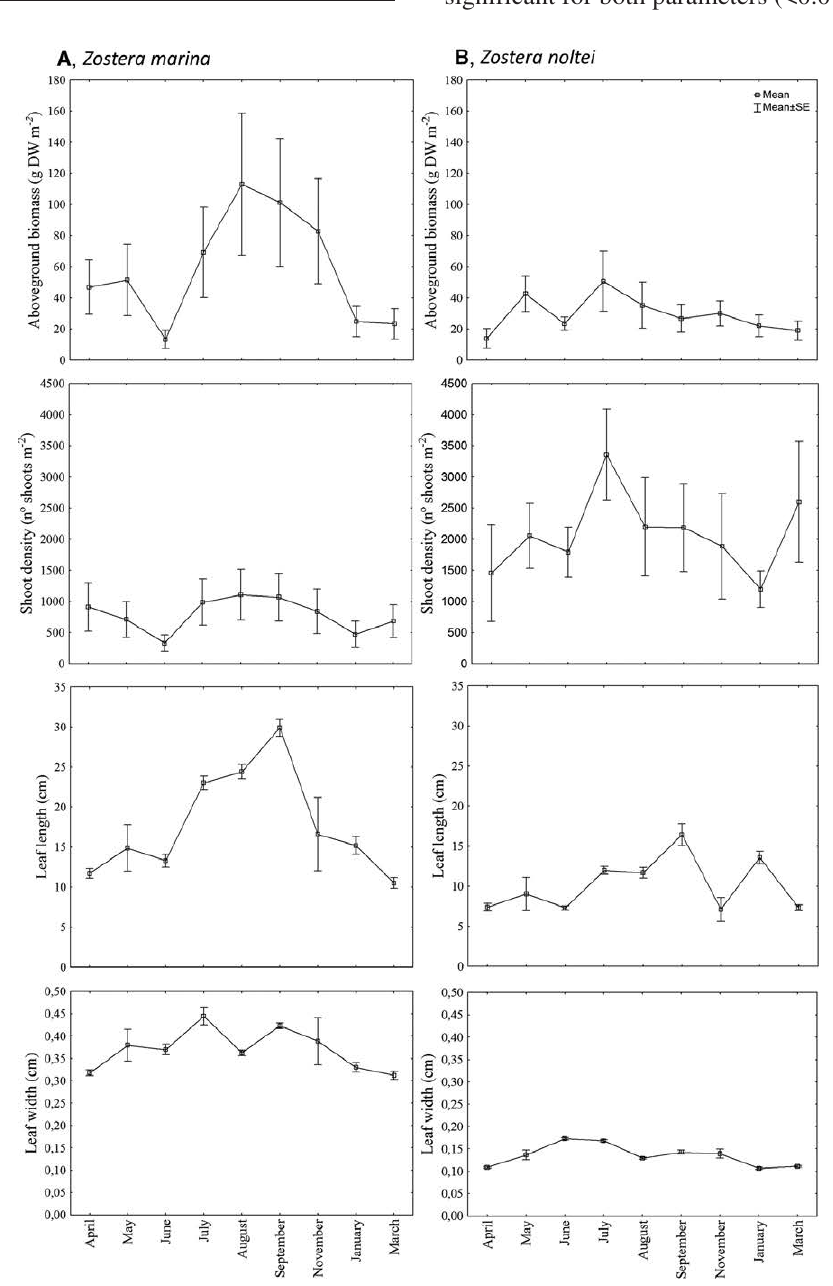
Fig. 2. – Seasonal mean±standard error (2000-2001) for aboveground biomass (g DW m –2 ), shoot density (no. shoots m –2 ), leaf length (cm) and leaf width (cm) in Zostera marina (A) and Zostera noltei beds